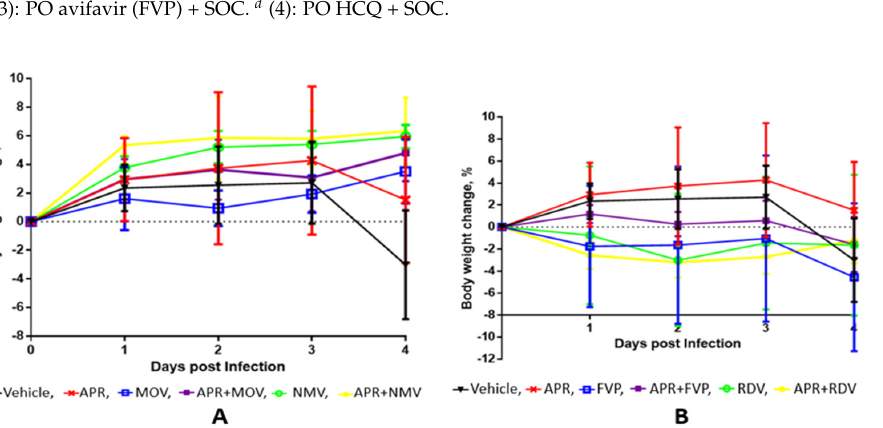
Figure 3. Weight change in drug-treated SARS-CoV-2 infected patients when used monotherapy ( A ) and combination therapy ( B ). ( A ) and combination therapy ( B